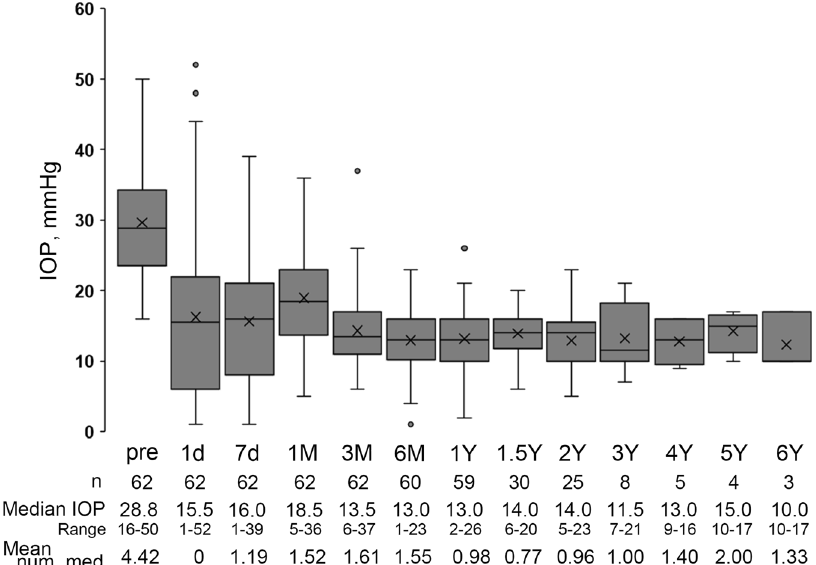
Figure 1. Box plots of the intraocular pressure (IOP) at each time point in all patients. The boxes represent the 25%, median, and 75% IOP, and the cross marks represent the mean